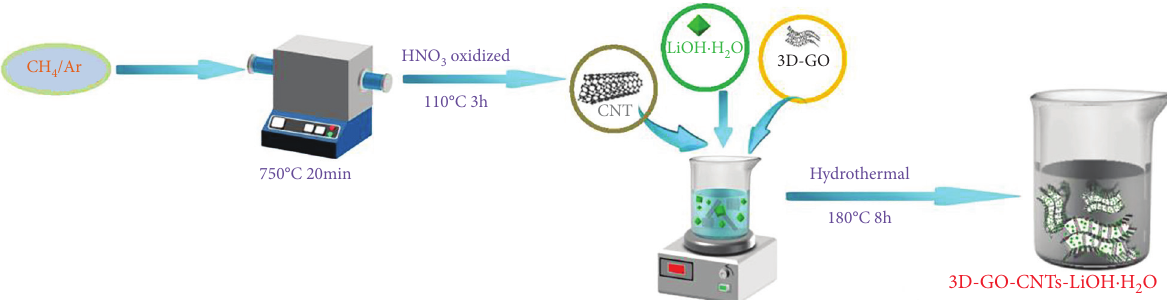
Figure 2: Preparation procedure of cellulose-based 3D-GO-CNTs-modified LiOH · H